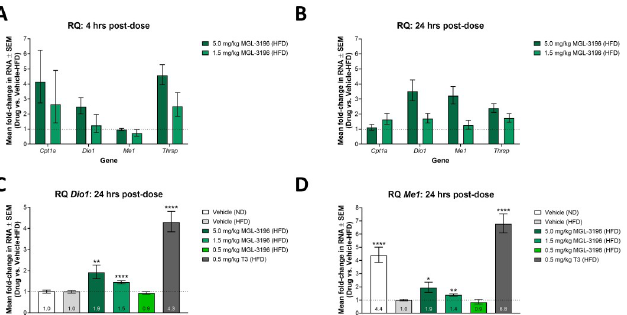
Fig 4. Modulation of liver gene expression after single-dose treatment of MGL-3196 or T3 in HFD fed rats. (A) After two weeks of consuming a HFD, animals were dosed once with vehicle (n = 6), 5.0 mg/kg MGL-3196 (n = 3), or 1.5 mg/kg MGL-3196 (n = 3). Four hrs later, the animals were sacrificed and liver Cpt1a , Dio1 , Me1 , and Thrsp RNA levels were quantified by RT-qPCR. Results are presented as expression relative to the expression levels in vehicle- control rats. Mean RQ values ± SEM are reported. (B) Animals were treated as in A) except that they were sacrificed 24 hrs post-dosing and gene expression analysis was conducted in the same manner. Results are presented as expression relative to the expression levels in vehicle-control rats. Mean RQ values ± SEM are reported. (C) The rats described in Fig 3 were sacrificed 24 hrs after compound treatment and liver Dio1 RNA levels were quantified by RT-qPCR. Results are presented as expression relative to the expression levels in HFD fed, vehicle-control rats. Mean RQ values ± SEM are reported with mean values annotated within the bars. Statistical analysis was performed using Brown-Forsythe and Welch ANOVA tests on the ΔΔ Ct values. The mean of each group was compared to the mean of the HFD fed, vehicle- control group; �� P < 0.01, ���� P < 0.0001. (D) Liver Me1 expression was quantified in the same rats as described in C) and in the same manner. Results are presented as expression relative to the expression levels in HFD fed, vehicle- control rats. Mean RQ values ± SEM are reported with mean values annotated within the bars. Statistical analysis was performed using Brown-Forsythe and Welch ANOVA tests on the ΔΔ Ct values. The mean of each group was compared to the mean of the HFD fed, vehicle-control group; � P < 0.05, �� P < 0.01, ���� P < 0.0001.